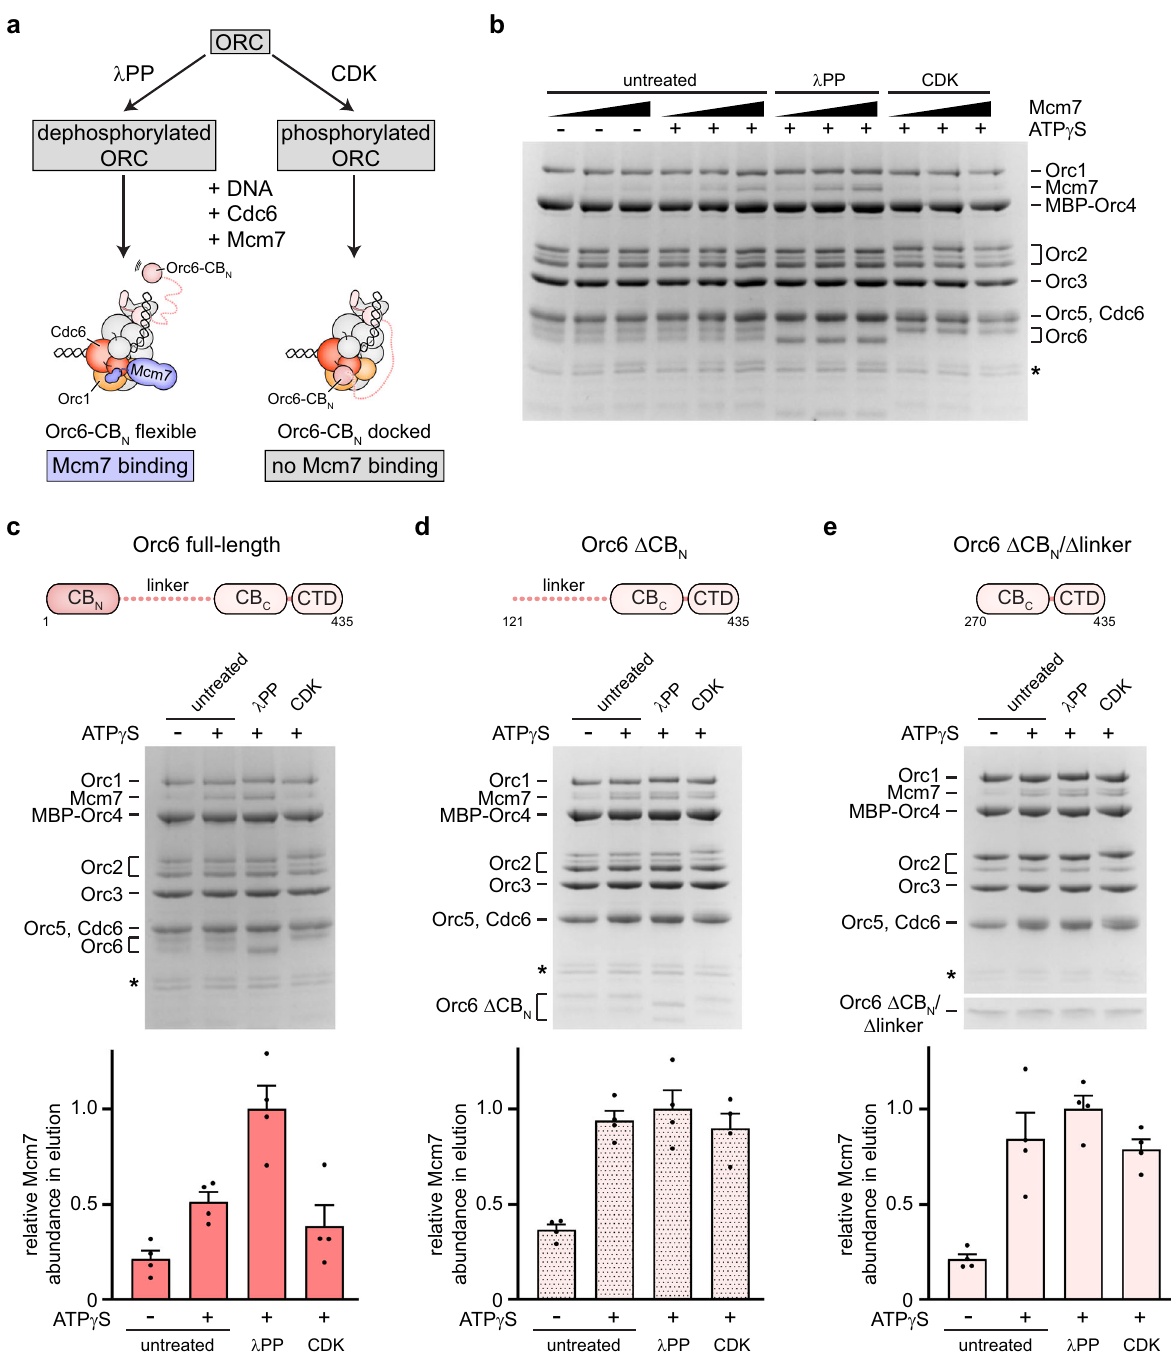
Fig. 5 Orc6-CB N is required for CDK-mediated inhibition of Mcm7 recruitment to Sc ORC·DNA·Cdc6. a Experimental work fl ow of Mcm7 recruitment assay. Docking of Orc6-CB N onto the ORC·Cdc6 ring is predicted to prevent binding of Mcm7. b Binding of Sc Mcm7 to Sc ORC·DNA·Cdc6 is increased after dephosphorylation and decreased upon CDK phosphorylation of ORC. Association of increasing amounts of Mcm7 with the initiator·co-loader was assessed in amylose pulldowns using ORC with MBP-tagged Orc4 as bait. c – e Deletion of Orc6-CB N abrogates the phosphorylation-dependent regulation of Sc Mcm7 binding to Sc ORC·DNA·Cdc6. Coomassie-stained SDS-PAGE gels of elutions from amylose pulldowns are shown in ( b – e ). The mean and standard error of the mean of Sc Mcm7 band intensities ( n = 4 independent recruitment assays) are plotted in ( c – e ). Note that Mcm7 migrates as a doublet and that Orc2 and the unstructured linker region of Orc6 Δ CB N are prone to proteolytic cleavage during expression and puri fi cation. Asterisks mark degradation products of ORC subunits that are stably integrated into ORC. In e , a higher percentage gel was used to visualize Orc6 Δ CB N / Δ linker due to its low molecular weight. SDS-PAGE gels of inputs from b – e are included in Supplementary Fig. 12. Source data are provided as a Source Data fi